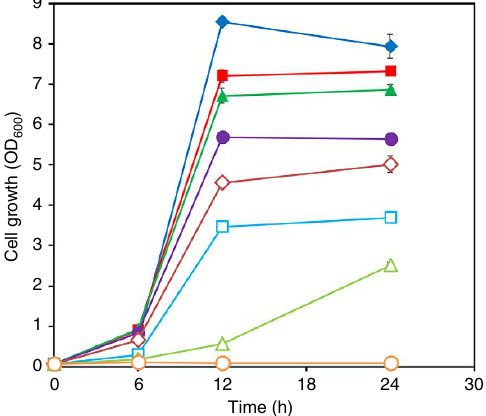
Figure 3 | Tolerance of E. coli to various concentrations of TPA disodium salt. The symbols represent the concentrations of TPA disodium salt tested as follows: filled diamond, 0gl (cid:2) 1 ; filled rectangle, 5gl (cid:2) 1 ; filled triangle, 10gl (cid:2) 1 ; filled circle, 20gl (cid:2) 1 ; open diamond, 30gl (cid:2) 1 ; open rectangle, 40gl (cid:2) 1 ; open triangle, 50gl (cid:2) 1 ; and open circle, 60gl (cid:2) 1 . Values and error bars represent the mean and s.d. of repeated